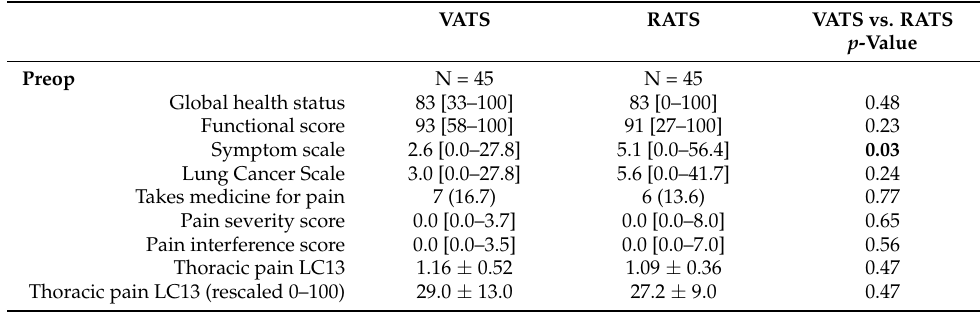
Table 6. QLQ-C30/LC13 and brief inventory pain in the matched RATS and VATS interventional